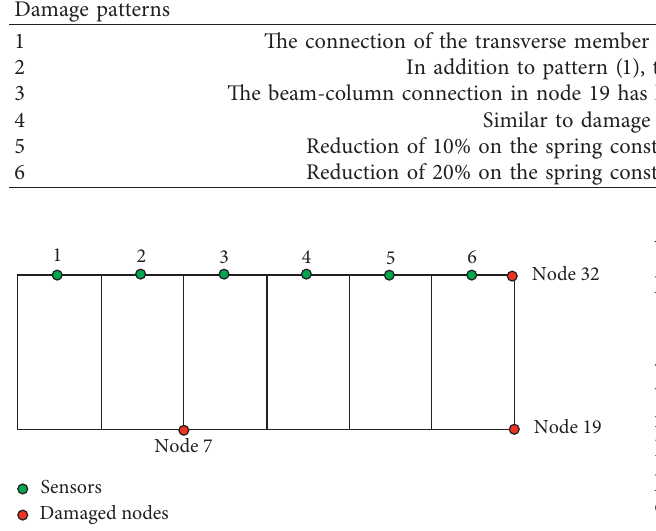
Figure 8: The sensor placement and the damaged nodes related to the BHM benchmark